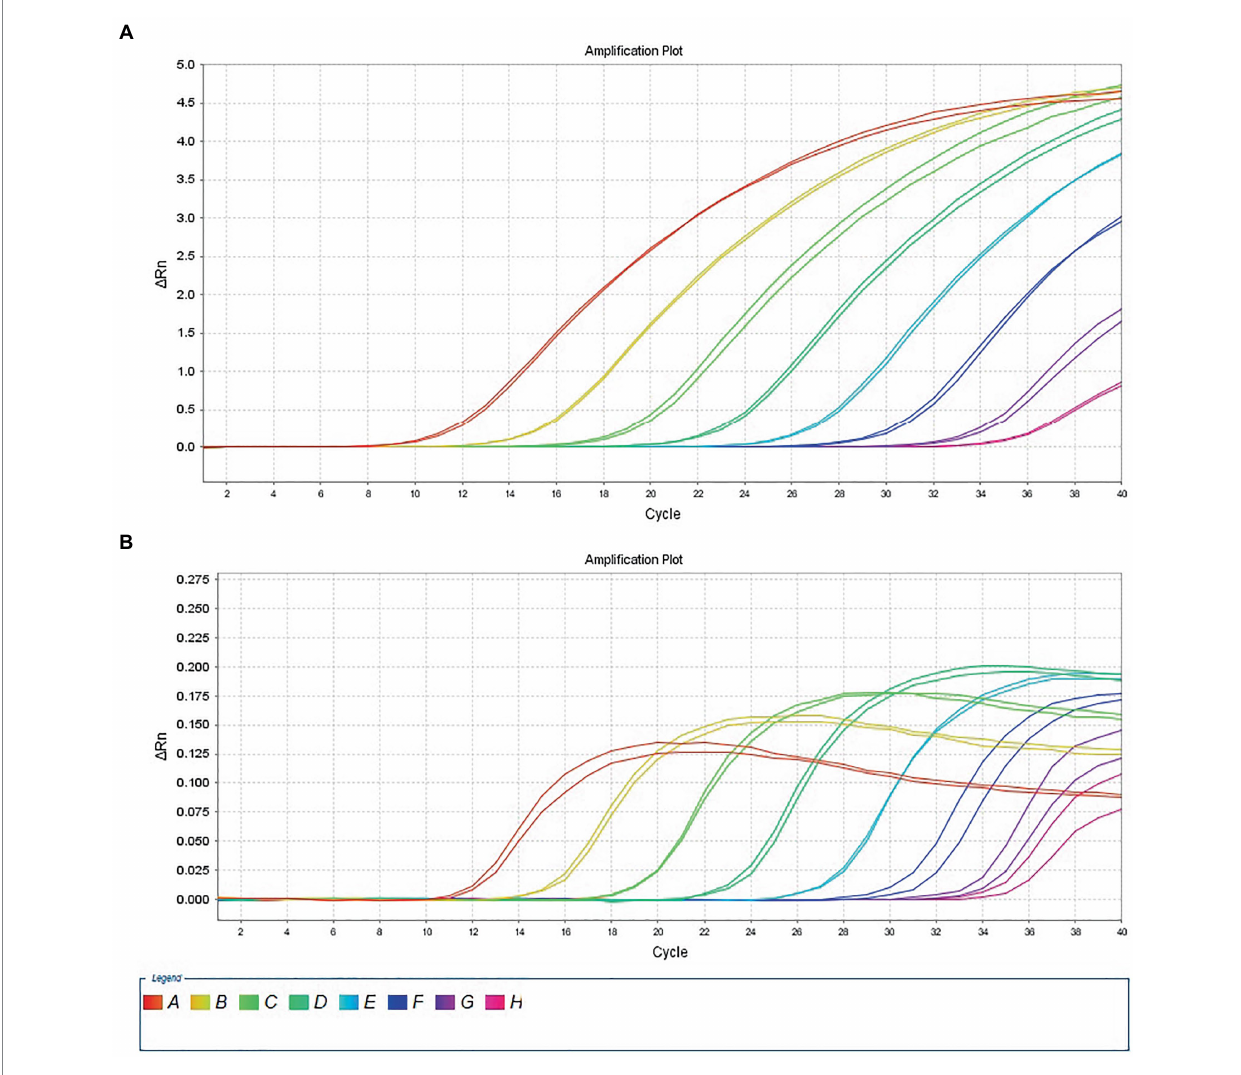
FIGURE 3 Sensitivity analysis of duplex TaqMan qPCR method for detection of Tembusu virus (A) and goose astrovirus (B) in mixed positive standard control. A to H represents standard template at 1.0 × 10 8 –1.0 × 10 1 copies/ μ L.